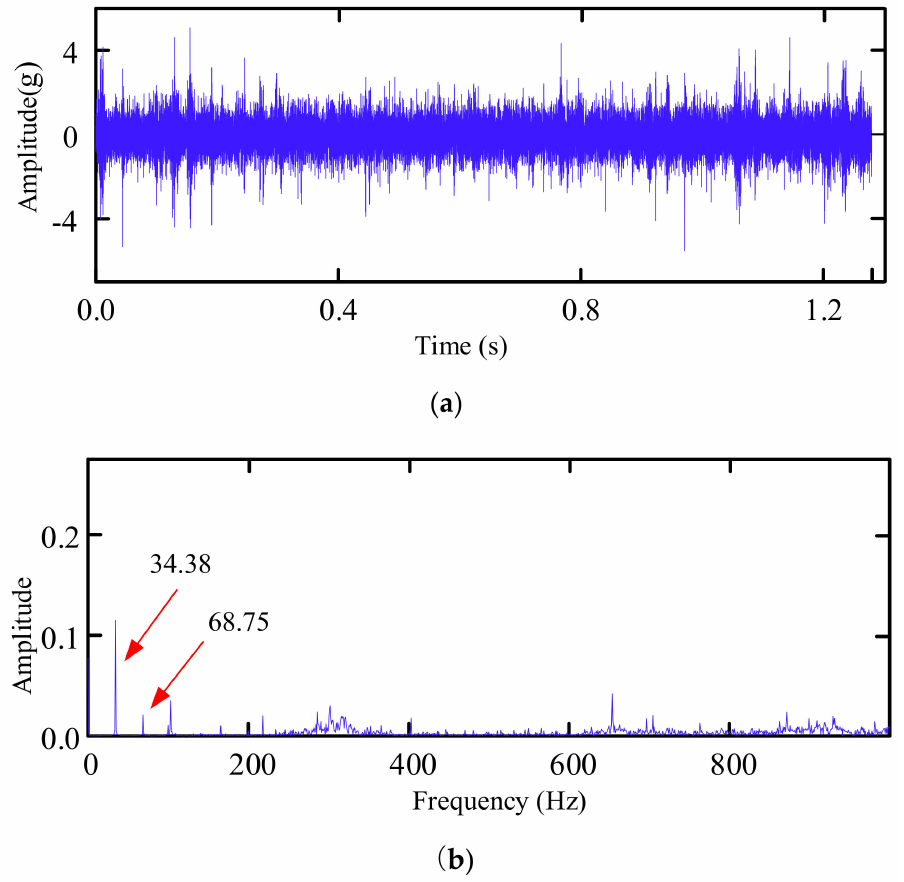
Figure 4. Time frequency domain diagram of original time series. ( a ) Time domain diagram of original time series. ( b ) Spectrum of original time